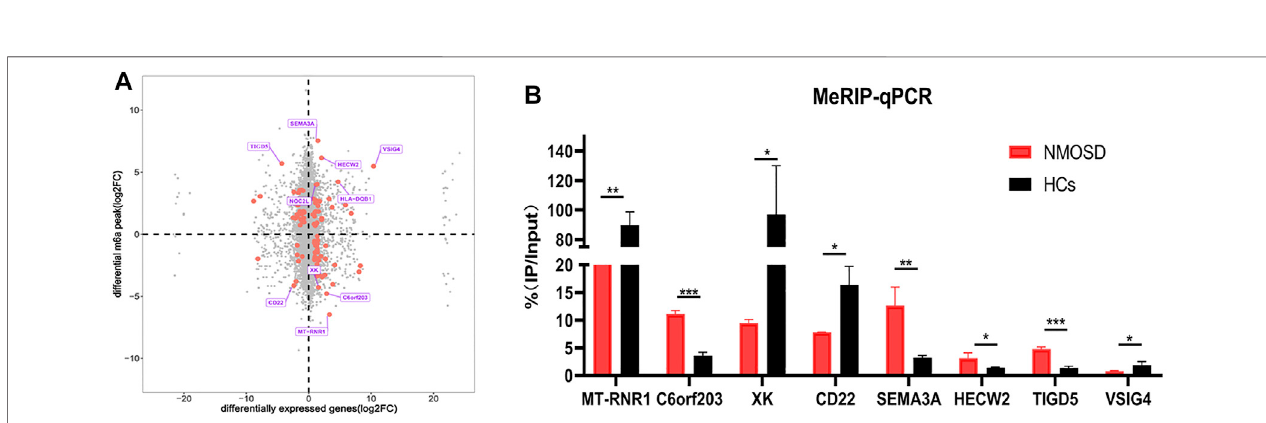
FIGURE 4 | Differential RNA modi fi cation and validation. (A) Analysis of differential RNA modi fi cation and differential gene expression. The X-axis represents the RNA-seq differential genes, and the Y-axis represents the RNA-modi fi ed differential peak genes; the top 10 genes (largest absolute values of diff.log2. fc) are shown in purple. The red dots represent signi fi cant differences (both RNA-seq and RNA modi fi cation data meet p < 0.05); the grey dots indicate that the data did not meet the condition required for the red dots. (B) Validation of the top four hypomethylated genes and the top four hypermethylated genes by using MeRIP-qPCR.